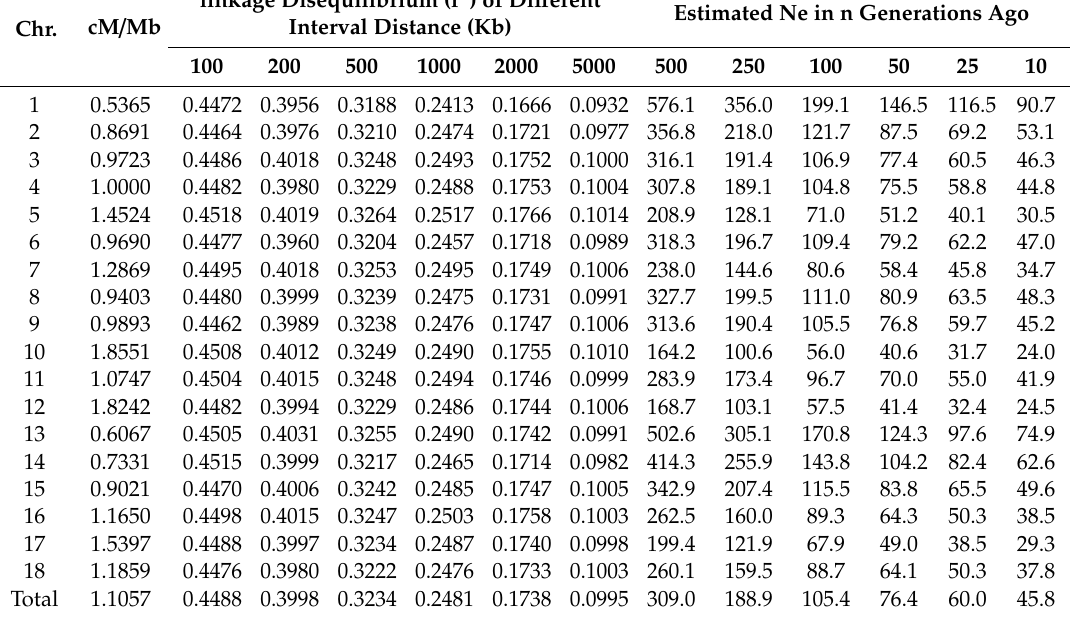
Table 1. The e ff ective population size over generations for Pi é train pigs estimated from linkage disequilibrium Table 1. The effective population size over generations for Piétrain pigs estimated from linkage disequilibrium data.